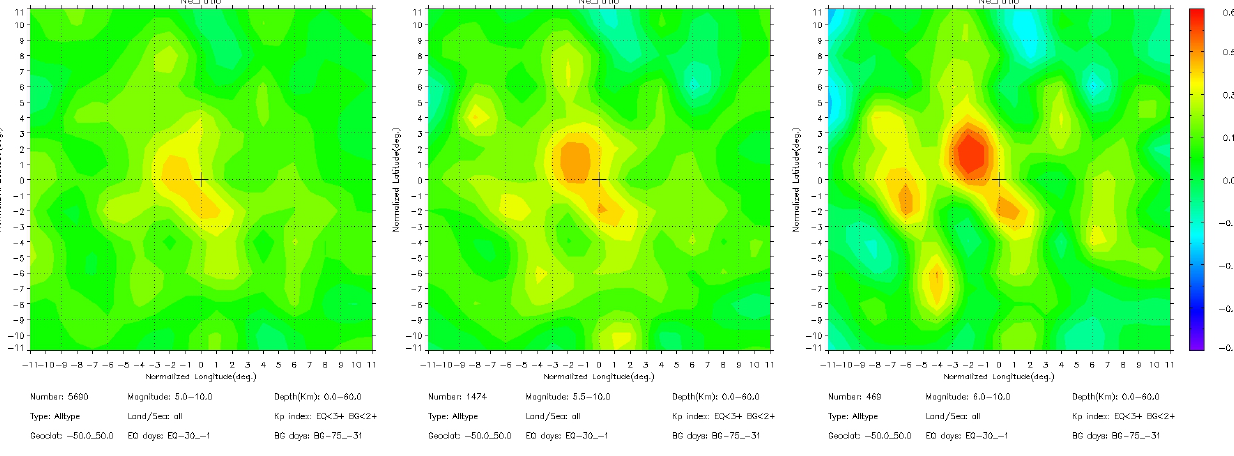
Fig. 5. The plots are similar to the right panel of Fig. 2, but it concerns statistical results of seismic events at different magnitude levels (left panel M s > =5.0, middle panel M s > =5.5, and right panel M s > =6.0). The left panel is similar to the one in Fig. 2 and is just here to facilitate the